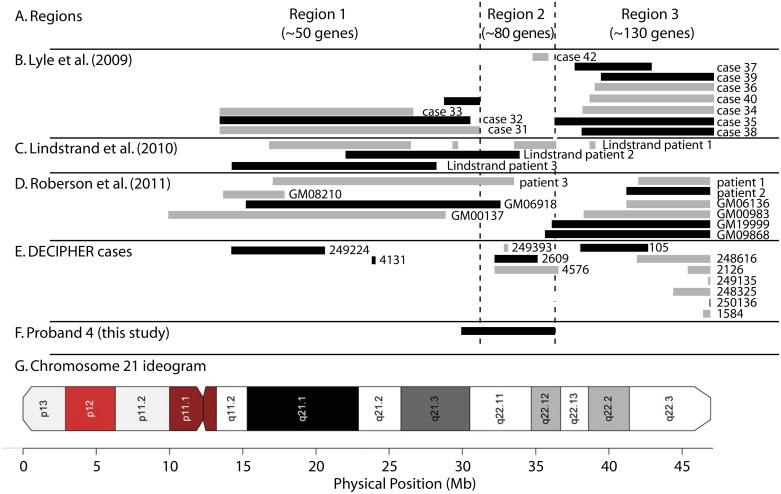
Heterozygous deletion of 6.5 Mb spanning a region of chromosome 21q in proband 4.This region is associated with agenesis of the corpus callosum. (A) We define three regions across the q arm of chromosome 21. (B) Extent of deletions reported by Lyle et al. [28]. (C) Three deletions reported by Lindstrand et al. [38]. (D) We previously reported chromosome 21 partial monosomy in three patients and additional cases from Coriell Repository [39]. (E) DECIPHER database cases spanning the chromosome. (F) Proband 4 (this study) has a hemizygous deletion that is notable for spanning the entirety of region 2, possibly accounting for the severe phenotype. (G) Chromosome 21 ideogram. This figure was adapted from [39] incorporating data on proband 4.